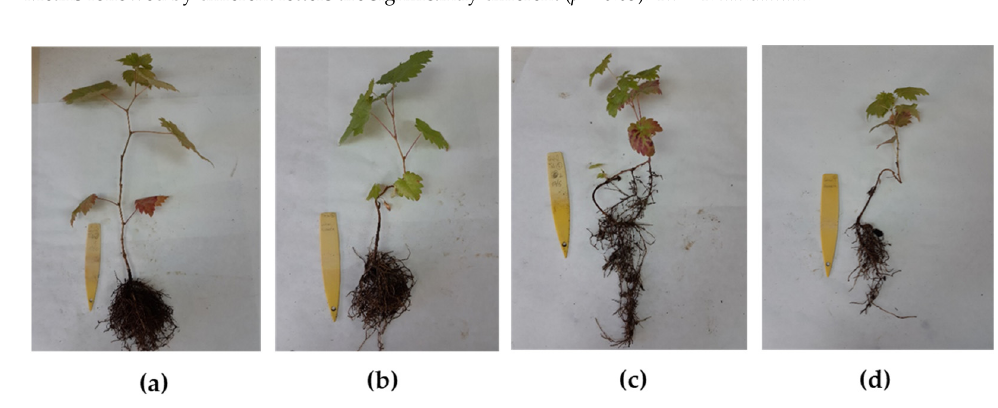
Table 8. Growth promotion effects of Trichoderma strains. Total, aerial, and root biomass lengths in cm (mean ± standard deviation) of grafted plant controls treated with T. harzianum and untreated (agar only). Data are referred to the experiment of protection against N. parvum . Treatment